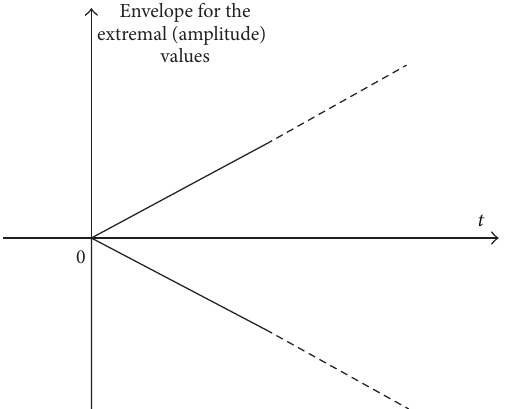
Figure 2: The envelope of resonant oscillations, according to the definition of resonance in [3, 4] and many other technical textbooks. When this steady state is attained?